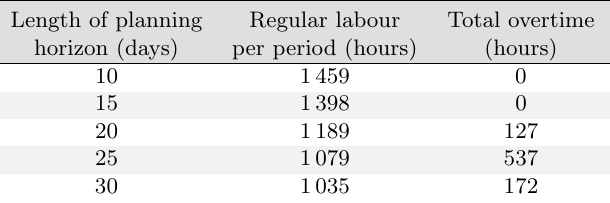
Table 3: Regular labour and overtime labour used per period for different planning horizons.